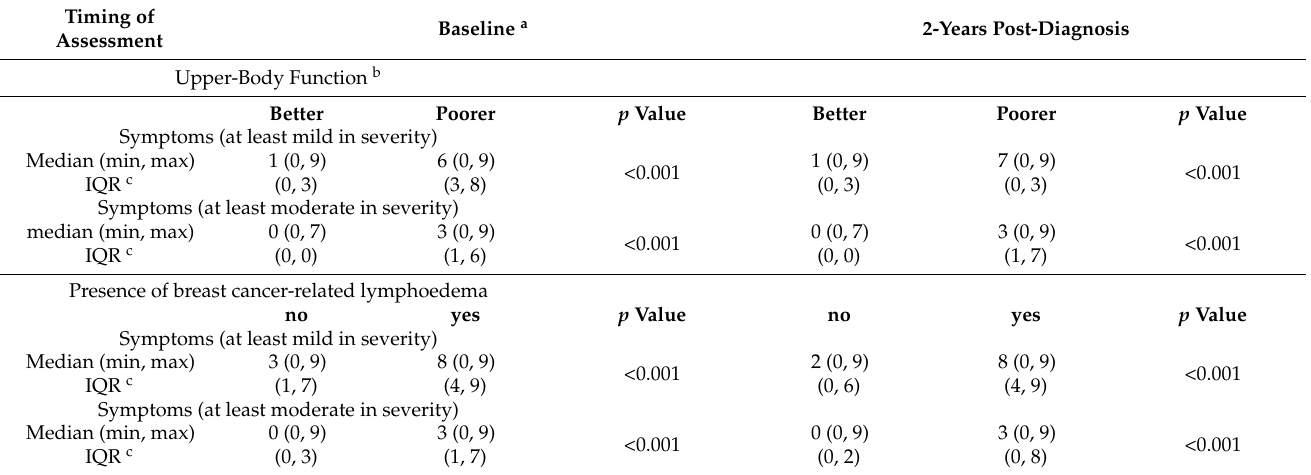
Table 4. Presence of upper-body symptoms (of mild severity or higher) for those with better versus lower upper-body function and those with and without breast cancer-related lymphoedema among participants in the Carolina Breast Cancer Study, Phase